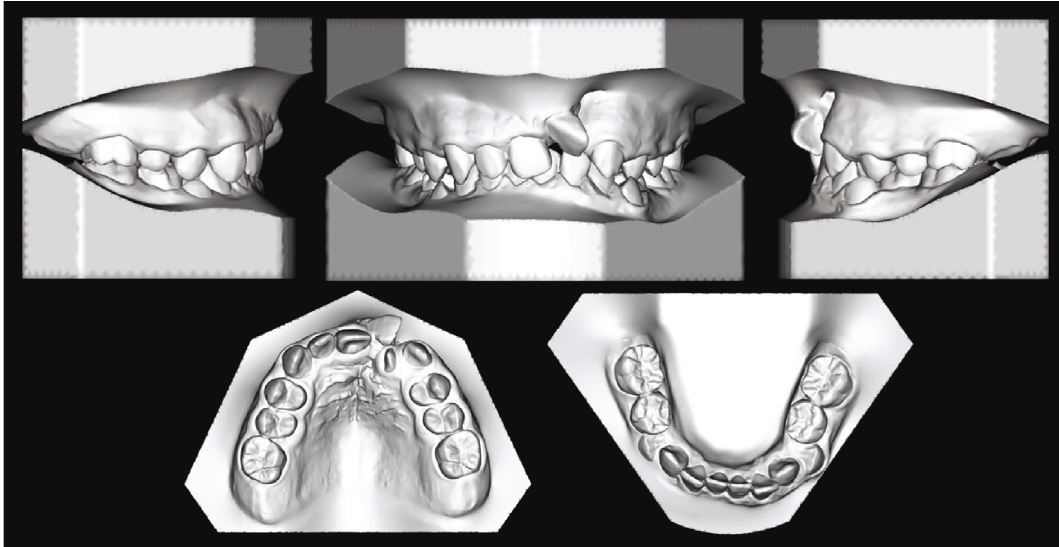
Figure 3: Initial dental casts.